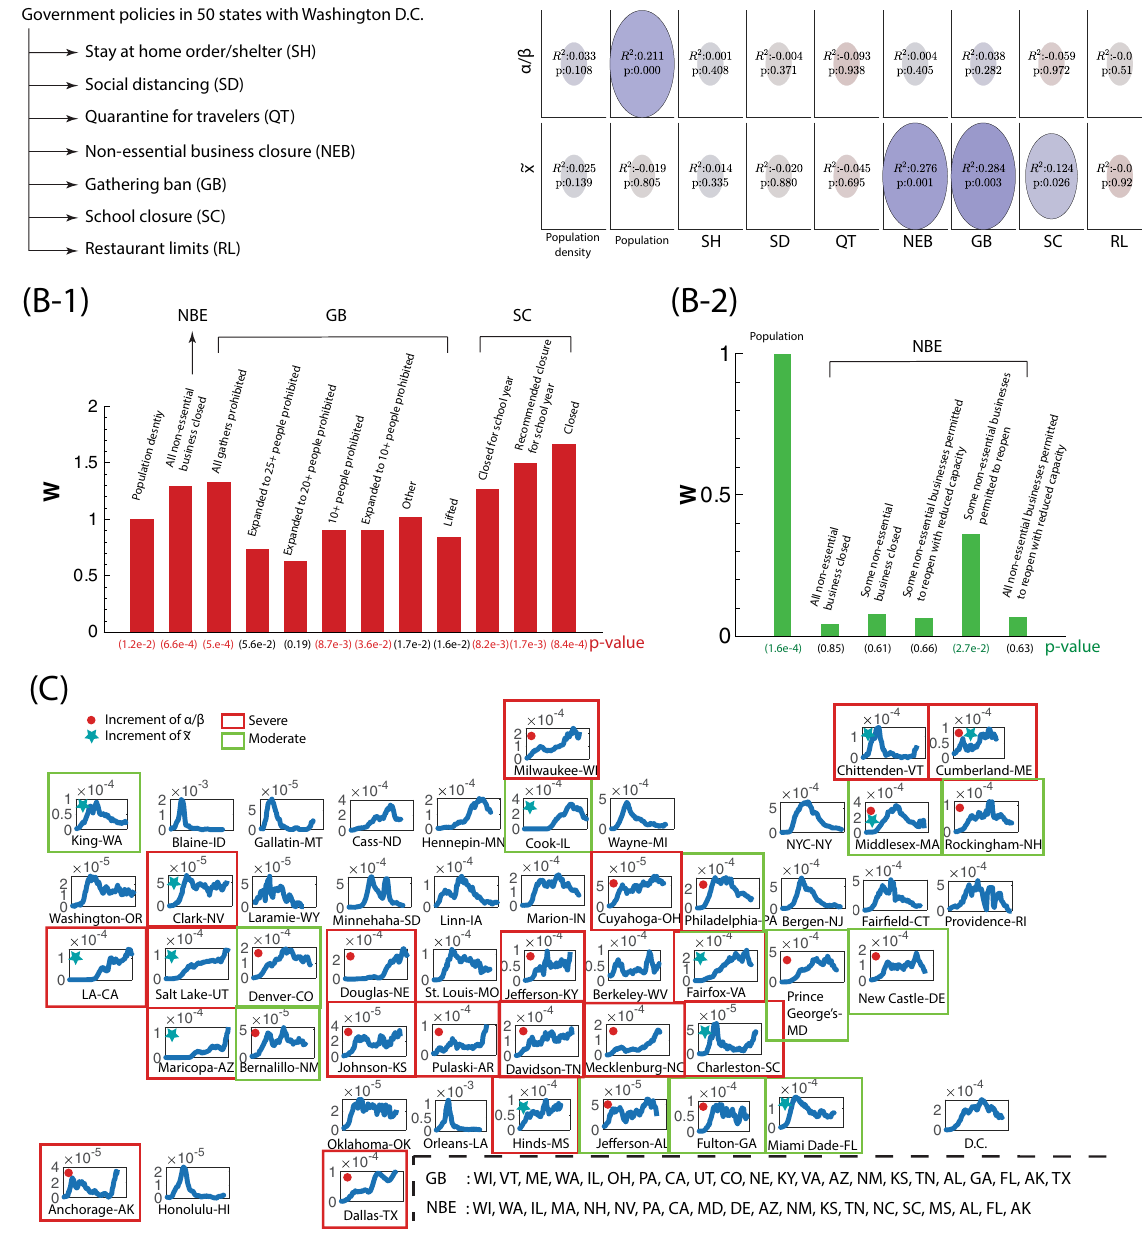
Figure 4. Evaluation of policies on COVID-19 transmissibility. ( A ) The relevance and significance of individual policy and population dynamics (population and population density) on model parameters α/β and ˜ x , characterized by adjusted R-square and p-values, respectively. In the diagram, the color of the ellipse represents the value of adjusted R 2 while the size of ellipse accounts for p-value. ( B ) The regression analysis of government policies and local population dynamics against (B-1) the projected eventual infection fraction ˜ x and (B-2) virulence α/β . The extent of influence from individual factor is reflected by the corresponding weight ( W ). In ( B ), the weights are normalized by the first factor. ( C ) Upon economy opening, the modification of polices impacts the trend of infection curve. We can identify the states with the surge of positive cases by the prediction of α/β and ˜ x using machine learning: the blue plots represent the daily increment (cid:31) n (7-day running averaged) normalized by the total population density N o in the leading county of all fifty states (including D.C.) For all emerging counties in each state, a red filled circle is recognized by the elevation of α/β from the prediction of the machine learning; A green filled star represents the increase of ˜ x ; the red square implies the severe situation based on the plateau/upward-trending daily growth and the yellow square indicates the moderate scenario based on the downward-trending daily growth